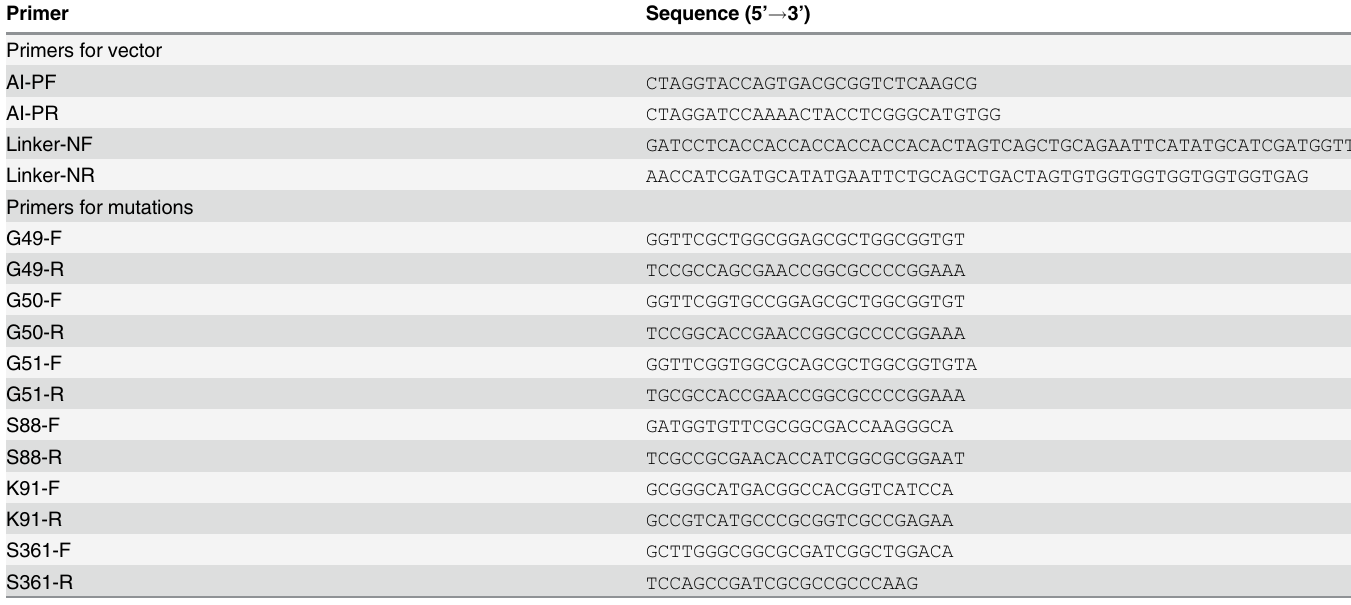
Table 1. Primers used in this